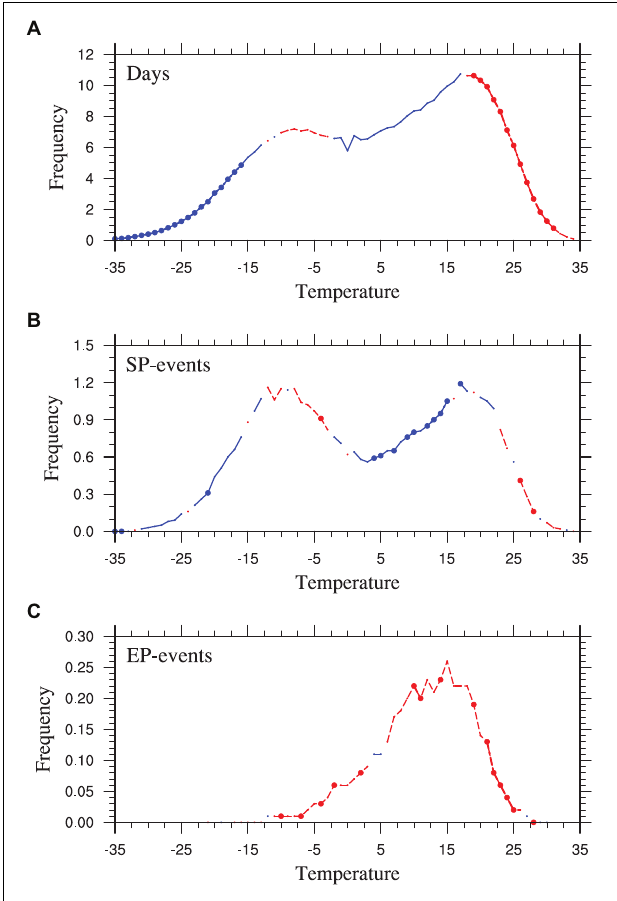
FIGURE 10 | (A) Average annual frequency of days with different daily mean temperatures. (B) Average annual frequency of SP events on days with different daily mean temperatures. (C) Average annual frequency of EP events on days with different daily mean temperatures. Plotted data represent the mean across all stations, calculated from data covering 1963–2017. Red (blue) lines indicate a positive (negative) linear trend over the 55 years; lines marked with dots show trends that are significant at the 95% confidence